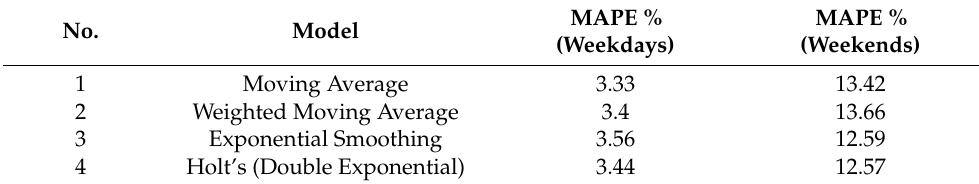
Table 2. MAPE comparison of time series